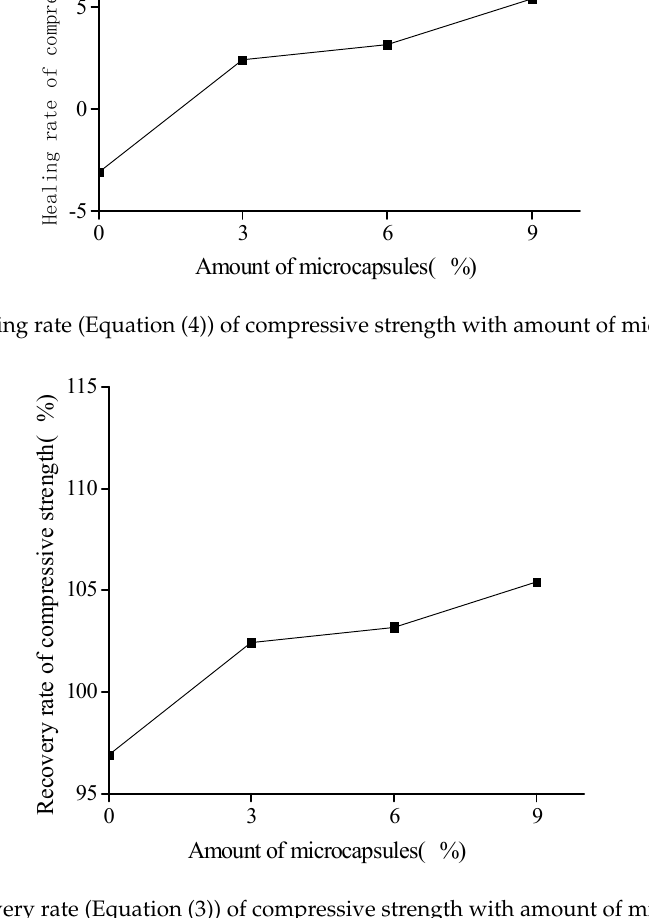
Figure 6. Recovery rate (Equation (3)) of compressive strength with amount of microcapsules.